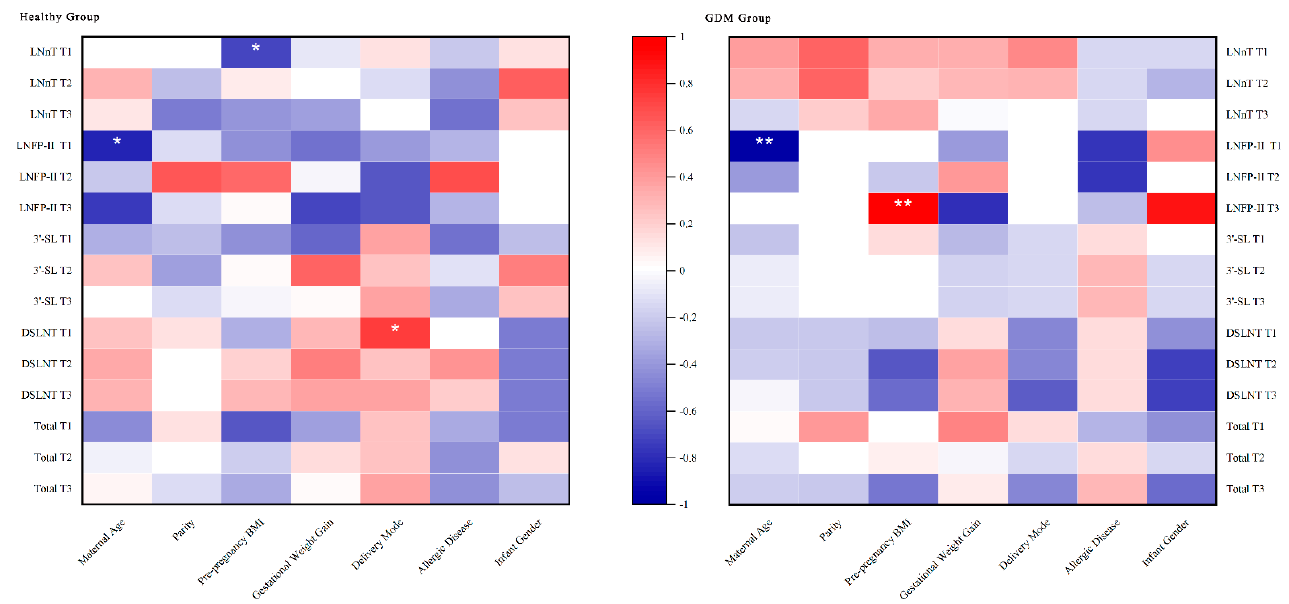
Figure 2. Spearman rank correlations between basic maternal and infant information and individual HMO concentrations in the two groups of the Se + Le + phenotype. T1, T2, and T3 represent colostrum (within 7 days), transitional milk (12–14 days), and mature milk (42 days), respectively. ** represents the correlation is significant at the 0.01 level (two-tailed). * represents the correlation is significant at the 0.05 level (two-tailed). Table 3. Effects of different levels of HMOs on infant growth and development in Se + Le +